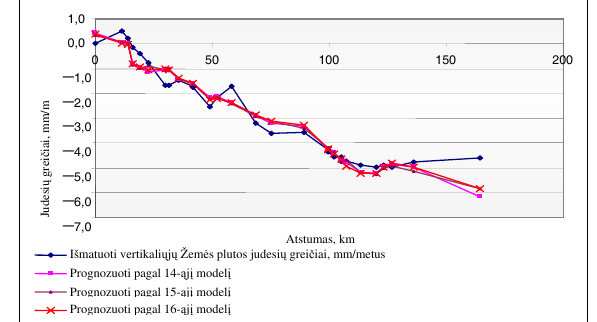
Fig 1. The graphs of measured and forecasted vertical earth crust movements at a line of Vilnius – Jonava (according to the